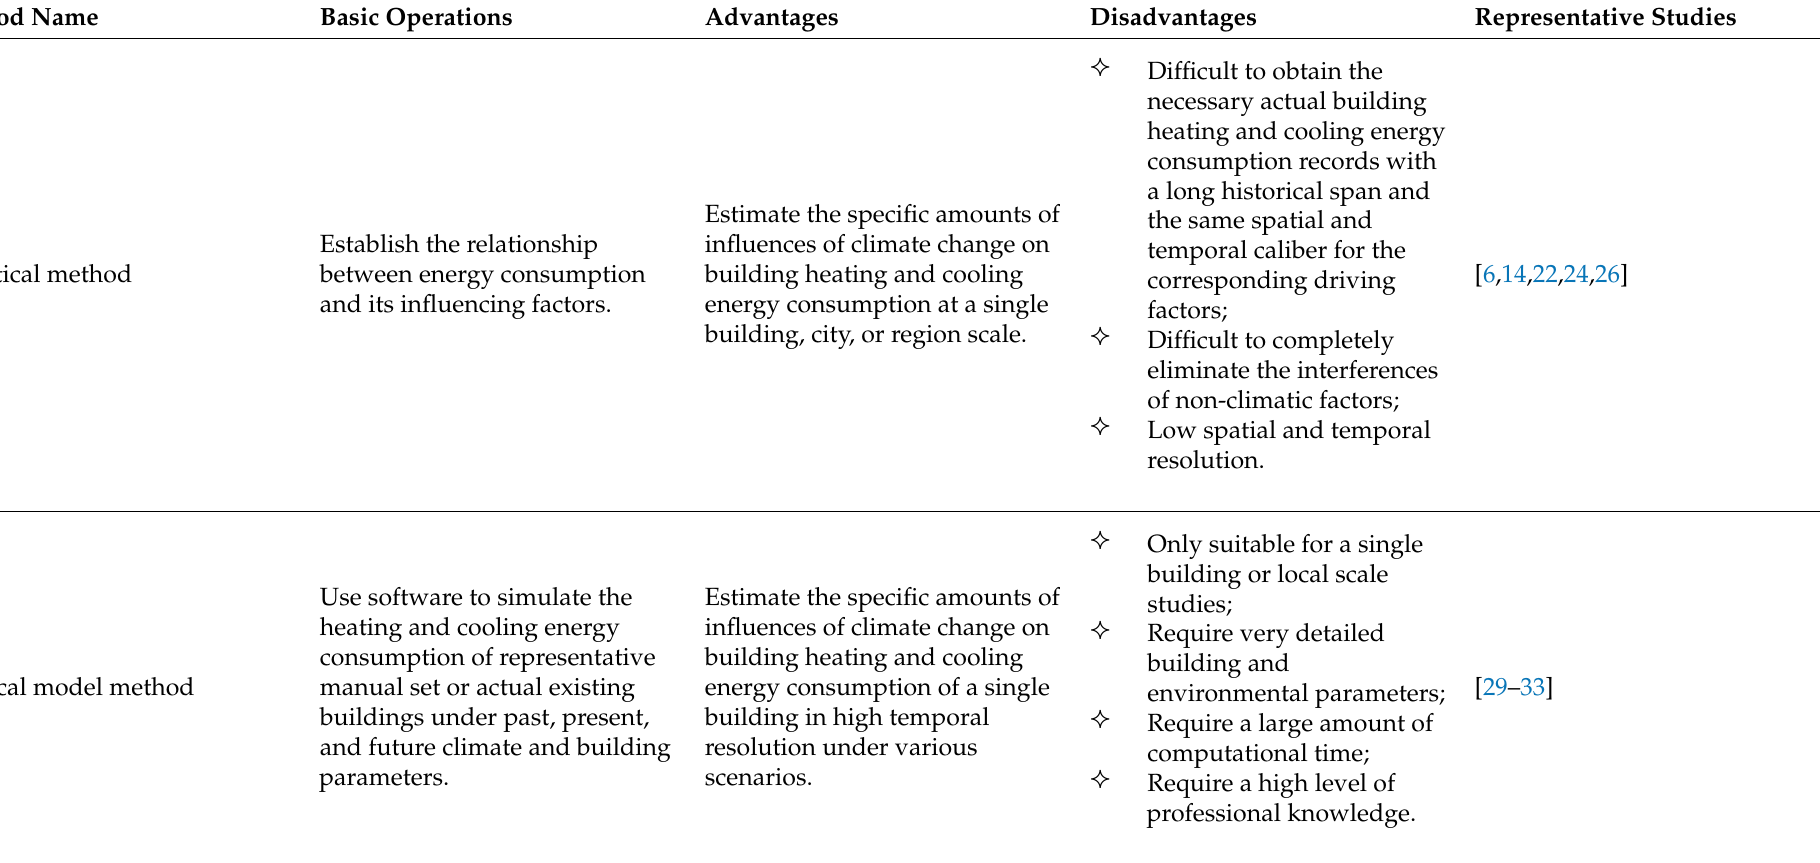
Table 1. Basic operations, advantages, and disadvantages of different methods used to estimate the impacts of climate change on the energy consumption of building heating and cooling.